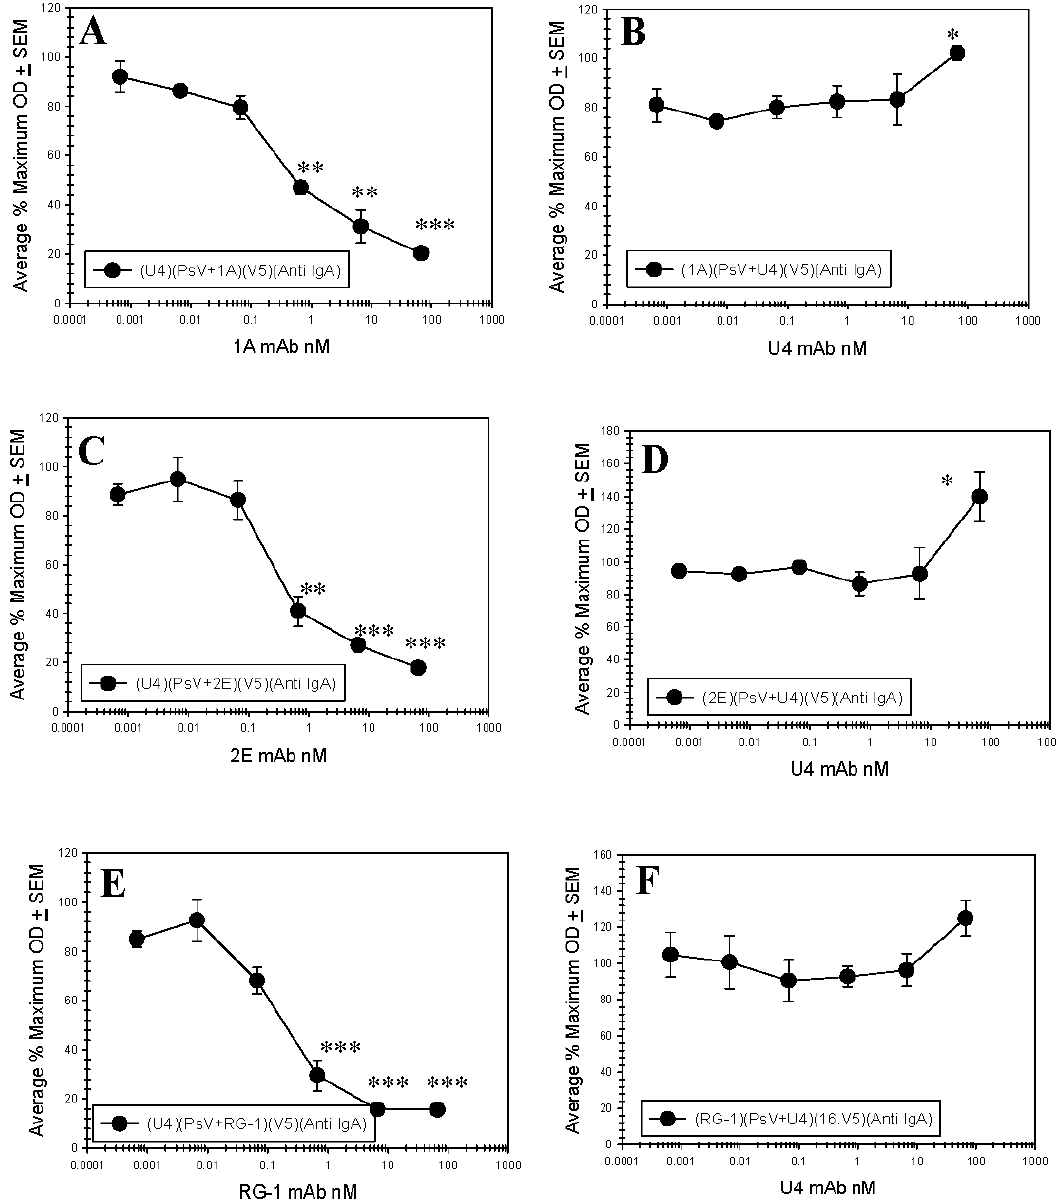
Figure 5. Anti-L1 and Anti-L2 mAb Competition Capture ELISAs . PsV16 pre-incubated with